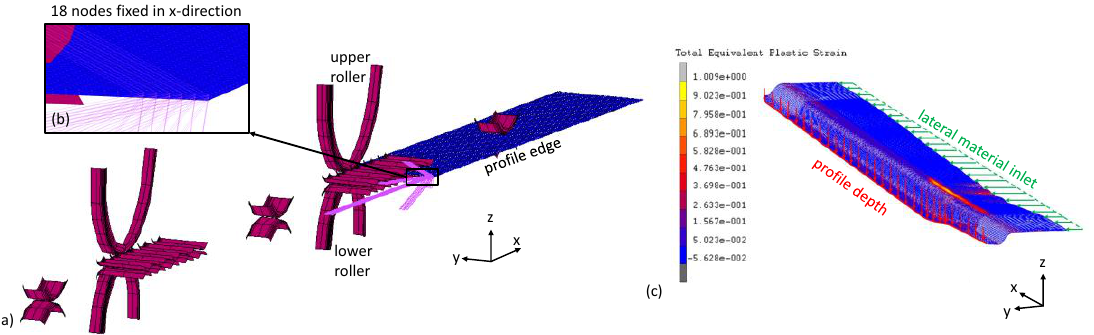
Figure 6. ( a ) Numerical model with two roll passes, ( b ) sheet fixing boundary conditions, and ( c ) deformed profile.